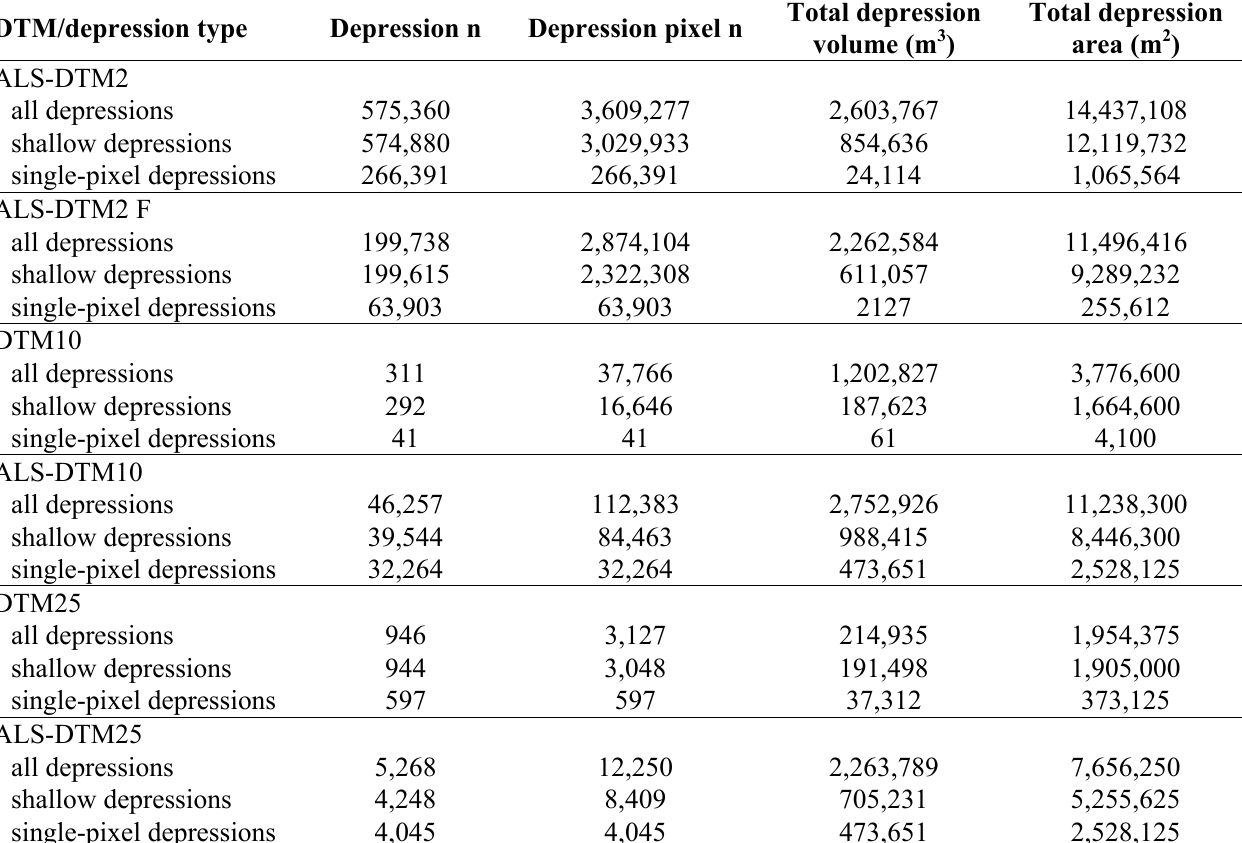
Table 4. Depression variables in Kainastonjoki River study